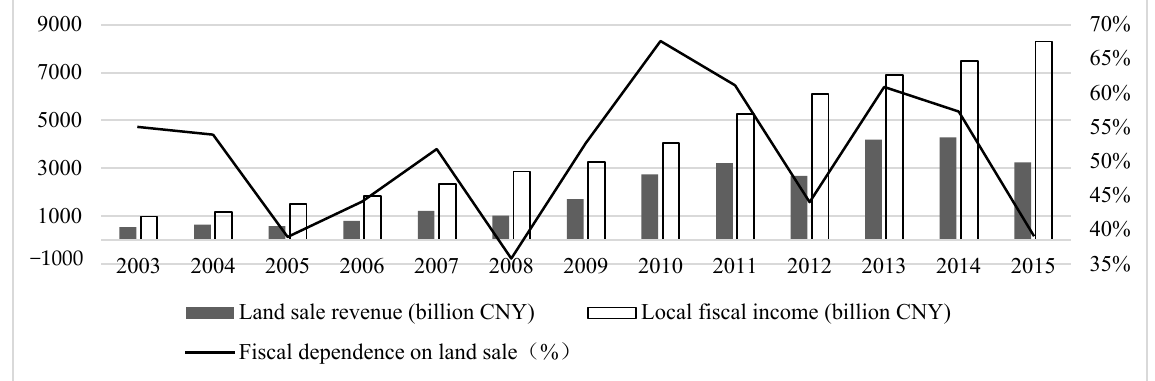
Figure 3. Fiscal dependence on land sale (2003–2015) . Data source: China Statistical Yearbook, China Land and Resources Statistical Yearbook.